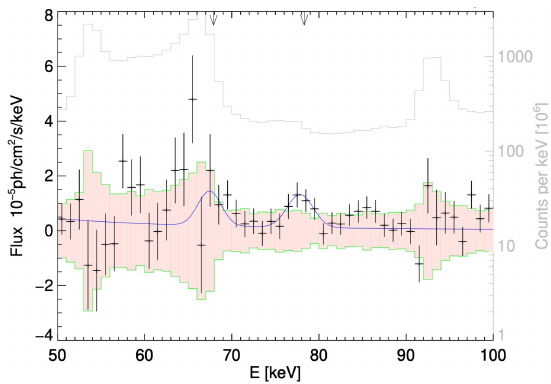
Figure 3. The signal of lines from 44 Sc de-excitation in Cas A is shown here, together with uncertainties remaining from the instrumental background model (redish hatched area). The instrumental background shape is shown as a histogram in grey. [From 15].